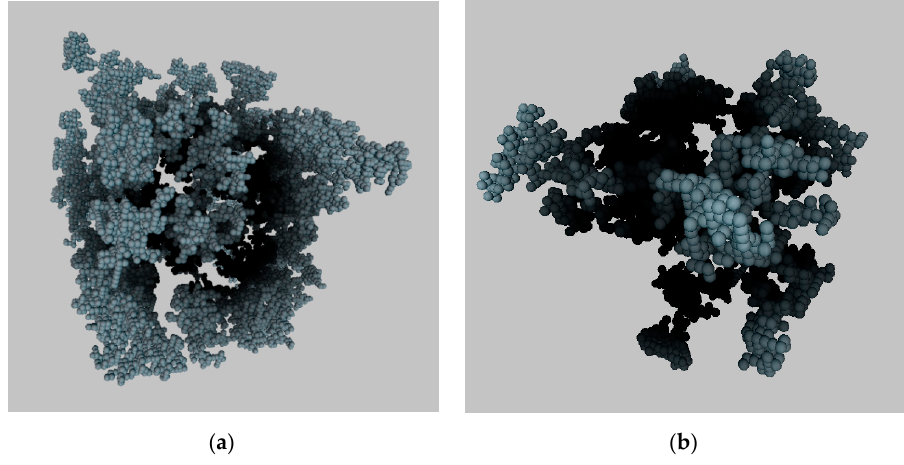
Figure 1. Digital 3D aerogels structure, generated with aggregation models: ( a ) DLA; ( b ) DLCA.